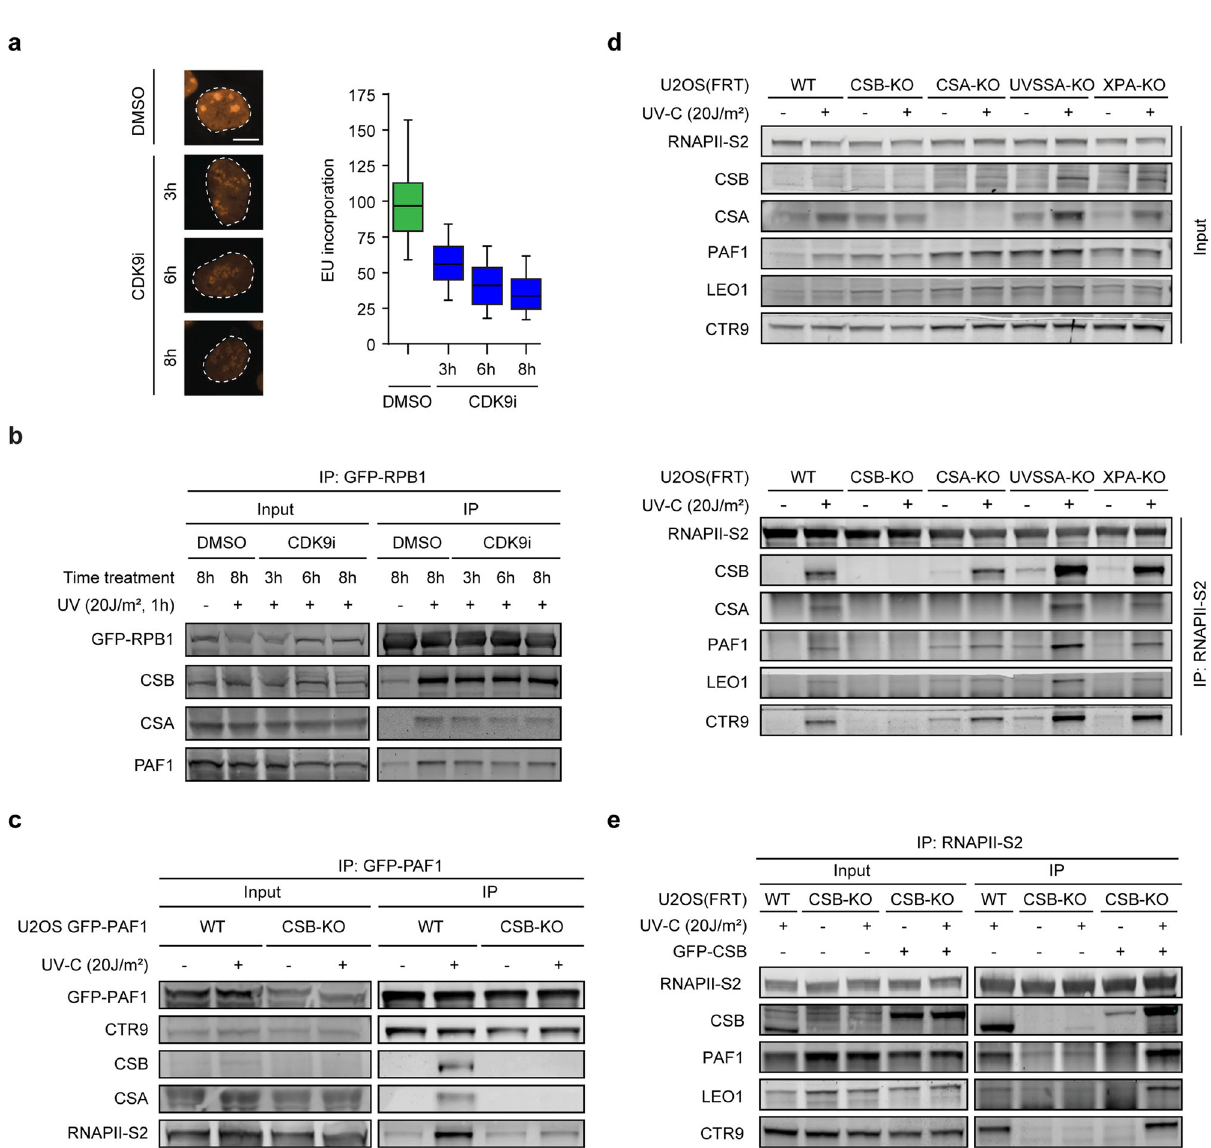
Fig. 2 The RNAPII – PAF1C interaction is mediated by CSB. a Representative images of U2OS cells treated with DMSO or 10 µ M LDC00067 (CDK9 inhibitor), followed by pulse-labeling with 5-ethynyl-uridine (5-EU). Scale bar indicates 10 µ m. Boxplots represent the median, 5th and 95th percentile of all cells of two independent experiments. b Co-immunoprecipitation of GFP-RPB1 in the presence of DMSO or 10 µ M LDC00067 for the indicated time. c Co-immunoprecipitation of GFP-PAF1 from U2OS cells (WT or CSB-KO). d Co-immunoprecipitation of endogenous RNAPII-S2 from U2OS cells (WT or indicated KO). e As in d , but now including U2OS CSB-KO cells reconstituted with GFP-CSB. b – e All co-immunoprecipitation fi gures are representative examples of at least two independent